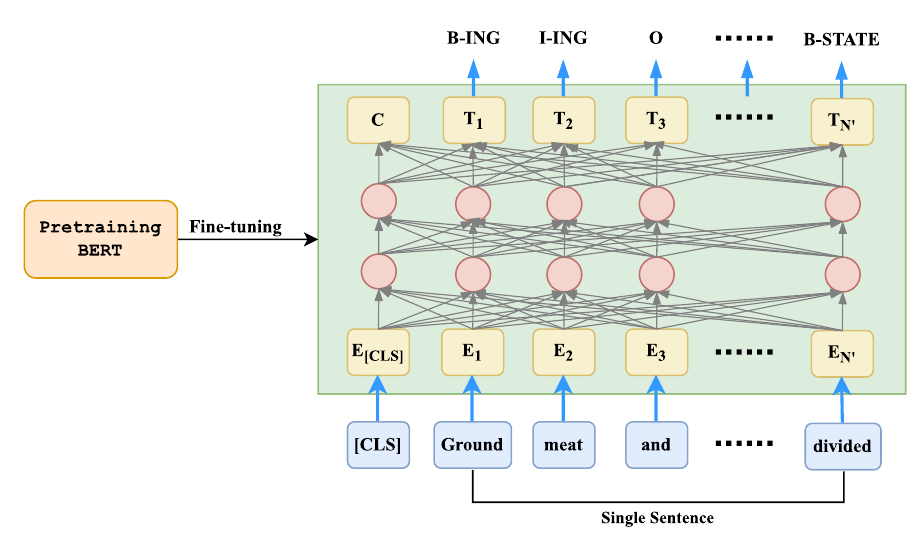
Figure 5. Fine-tuned BERT for FINER.